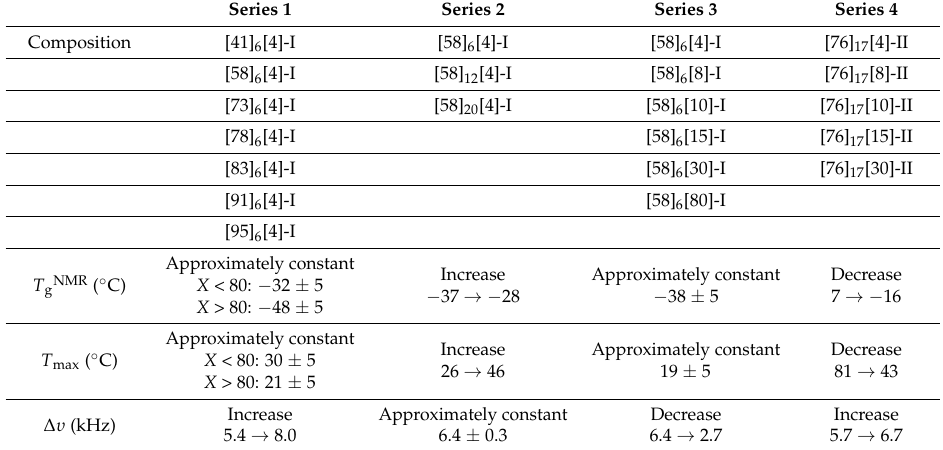
Table 2. Trends for T gNMR , T max , and ∆ ν with an increase of the X , n , and Y parameters of Types I and II ormolytes (hybrid organic-inorganic ionic conductors). Adapted from Mello et al. [76].